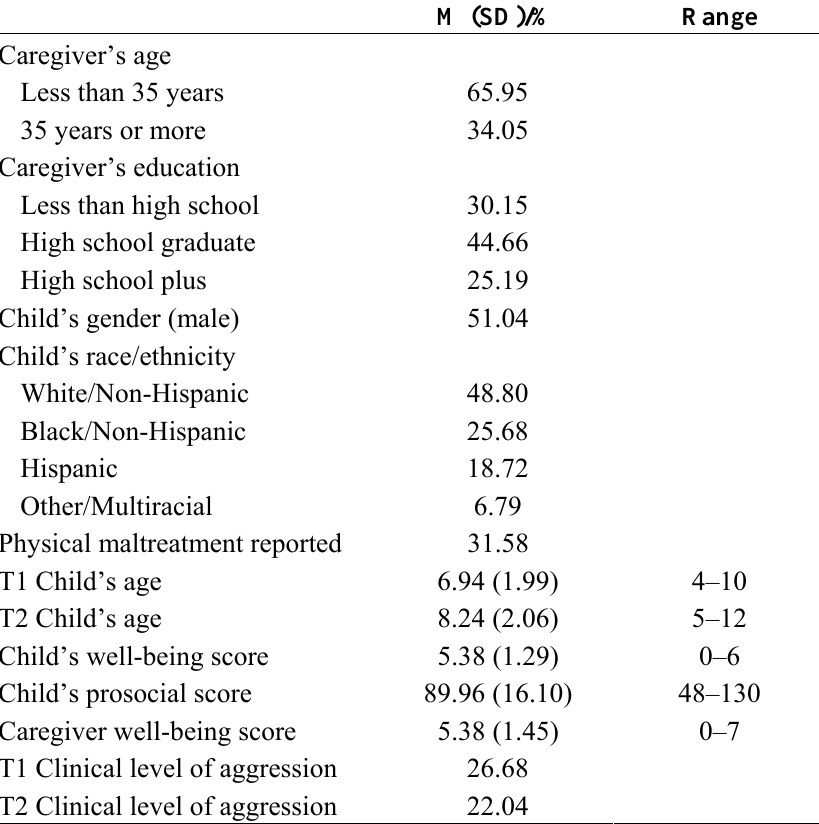
Table 1. Characteristics of the sample (n =